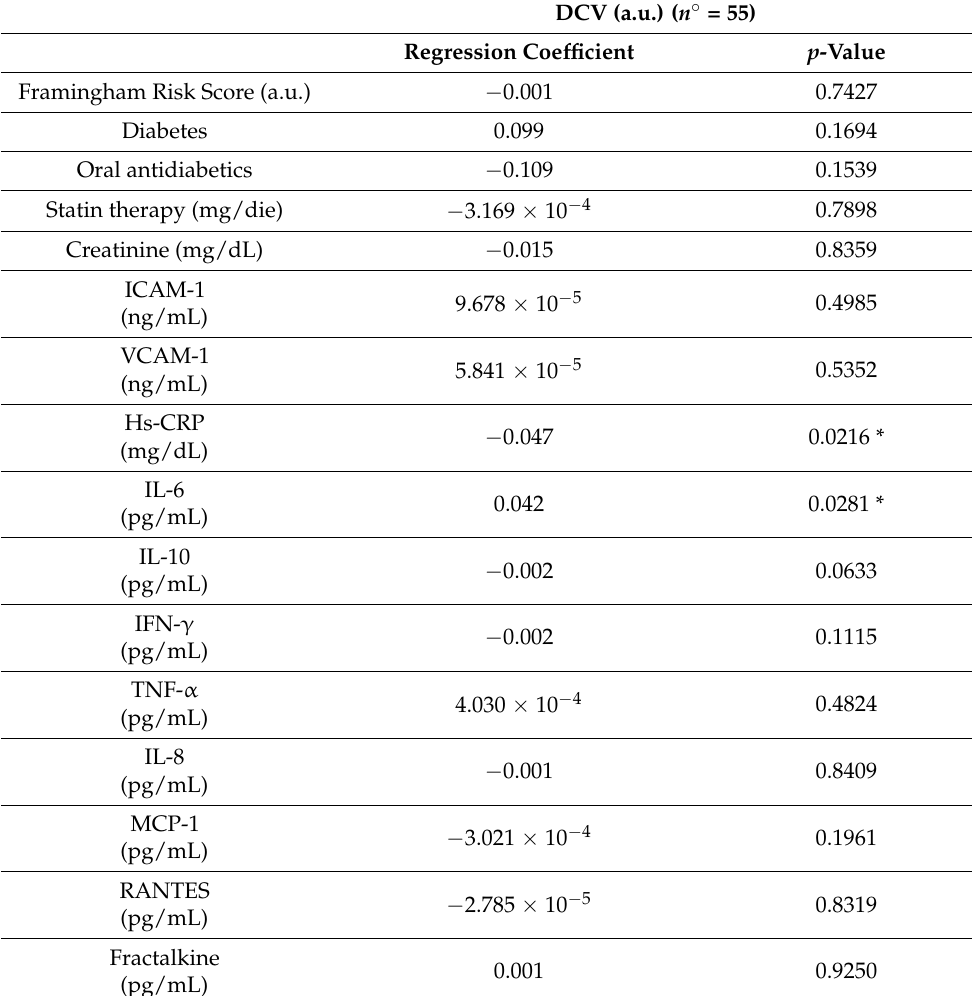
Table 2. Multiple regression between clinical and biohumoral parameters and DCV (model 1 adjustment).